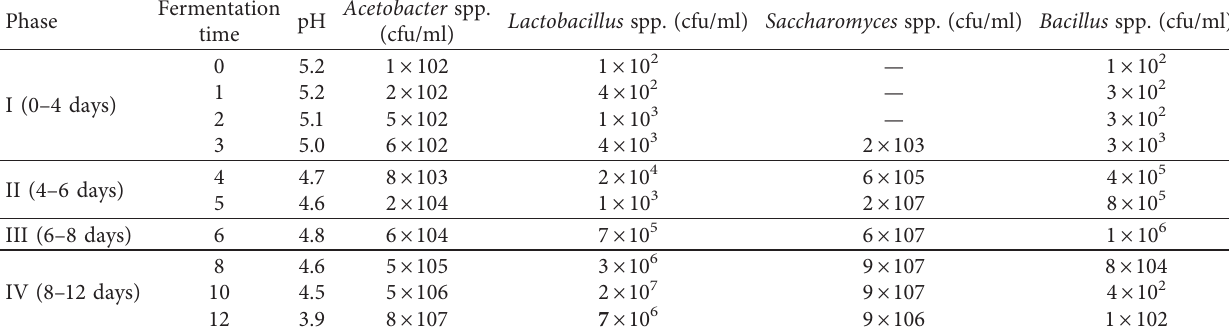
Table 1: Changes in moisture content, pH, and microbial count occurring during the fermentation of Tella. Phase